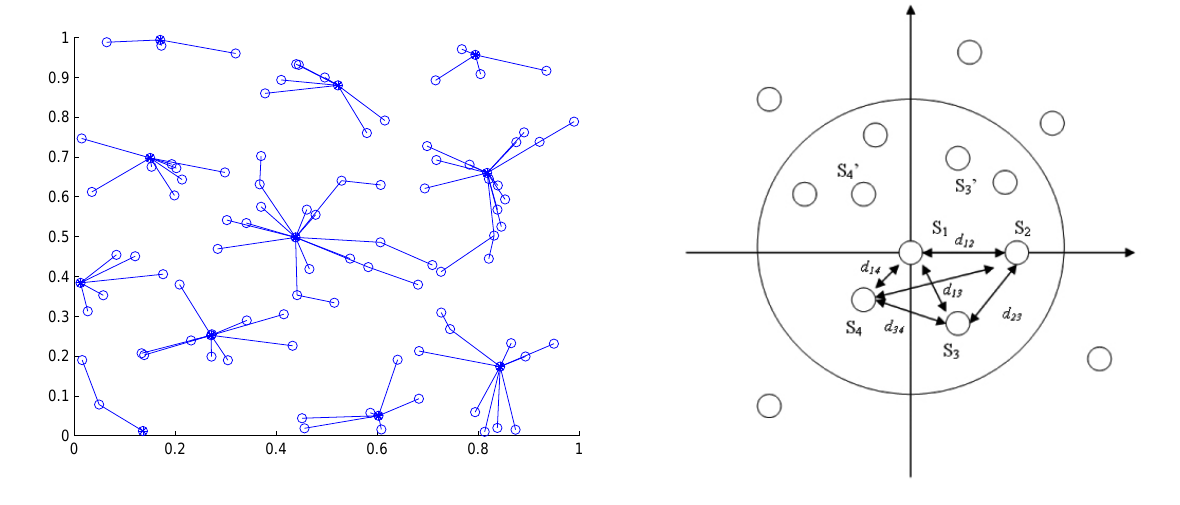
Figure 1. Clusters are formed in a random network of 100 sensors (left); The estimation procedures of ad-hoc wireless sensor networks in the two-dimensional space with sufficient connectivity. Sensor 1, 2 and 3 are considered as a group to form the basis for the local coordinate system. Since there are two possible locations of sensor 3, either S related local coordinate systems are formed due to the mirror property of the cluster